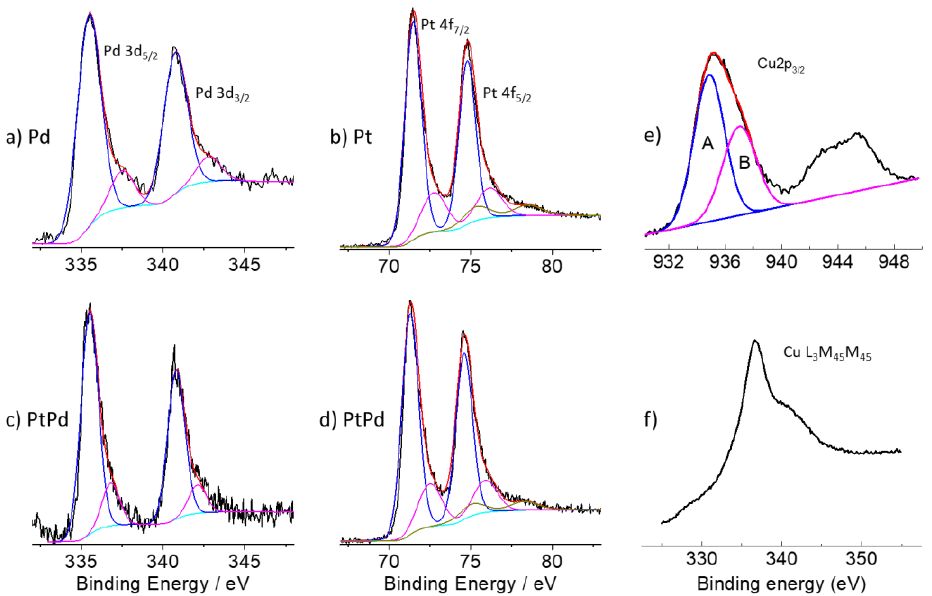
Figure 2. Photoelectron spectra of the regions: ( a , c ) Pd 3d of Pd-GP, and Pt 80 Pd 20 -GP, respectively. The 3d 5/2 —3d 3/2 spin-orbit doublets (blue and magenta line) refer to the Pd 0 and Pd(II) states, respectively; ( b , d ) Pt 4f of Pt-GP, and Pt 80 Pd 20 -GP, respectively. The 4f 7/2 —4f 5/2 spin-orbit doublets (blue, magenta, and dark yellow line) refer to Pt 0 , Pt(II) and Pt(IV) states, respectively. The cyan line refers to the background and the red line superimposed to the experimental data, referring to the sum of all of the Gaussian components; ( e , f ) Cu 2p 3/2 and Cu L 3 M 45 M 45 Auger peak of Cu(OH) 2